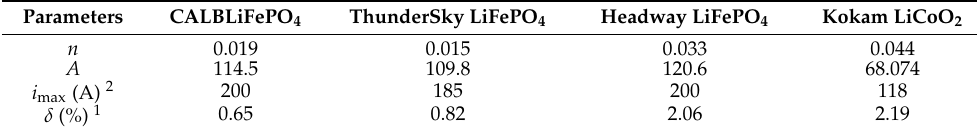
Table 4. Optimal values of parameters for classical Peukert’s Equation